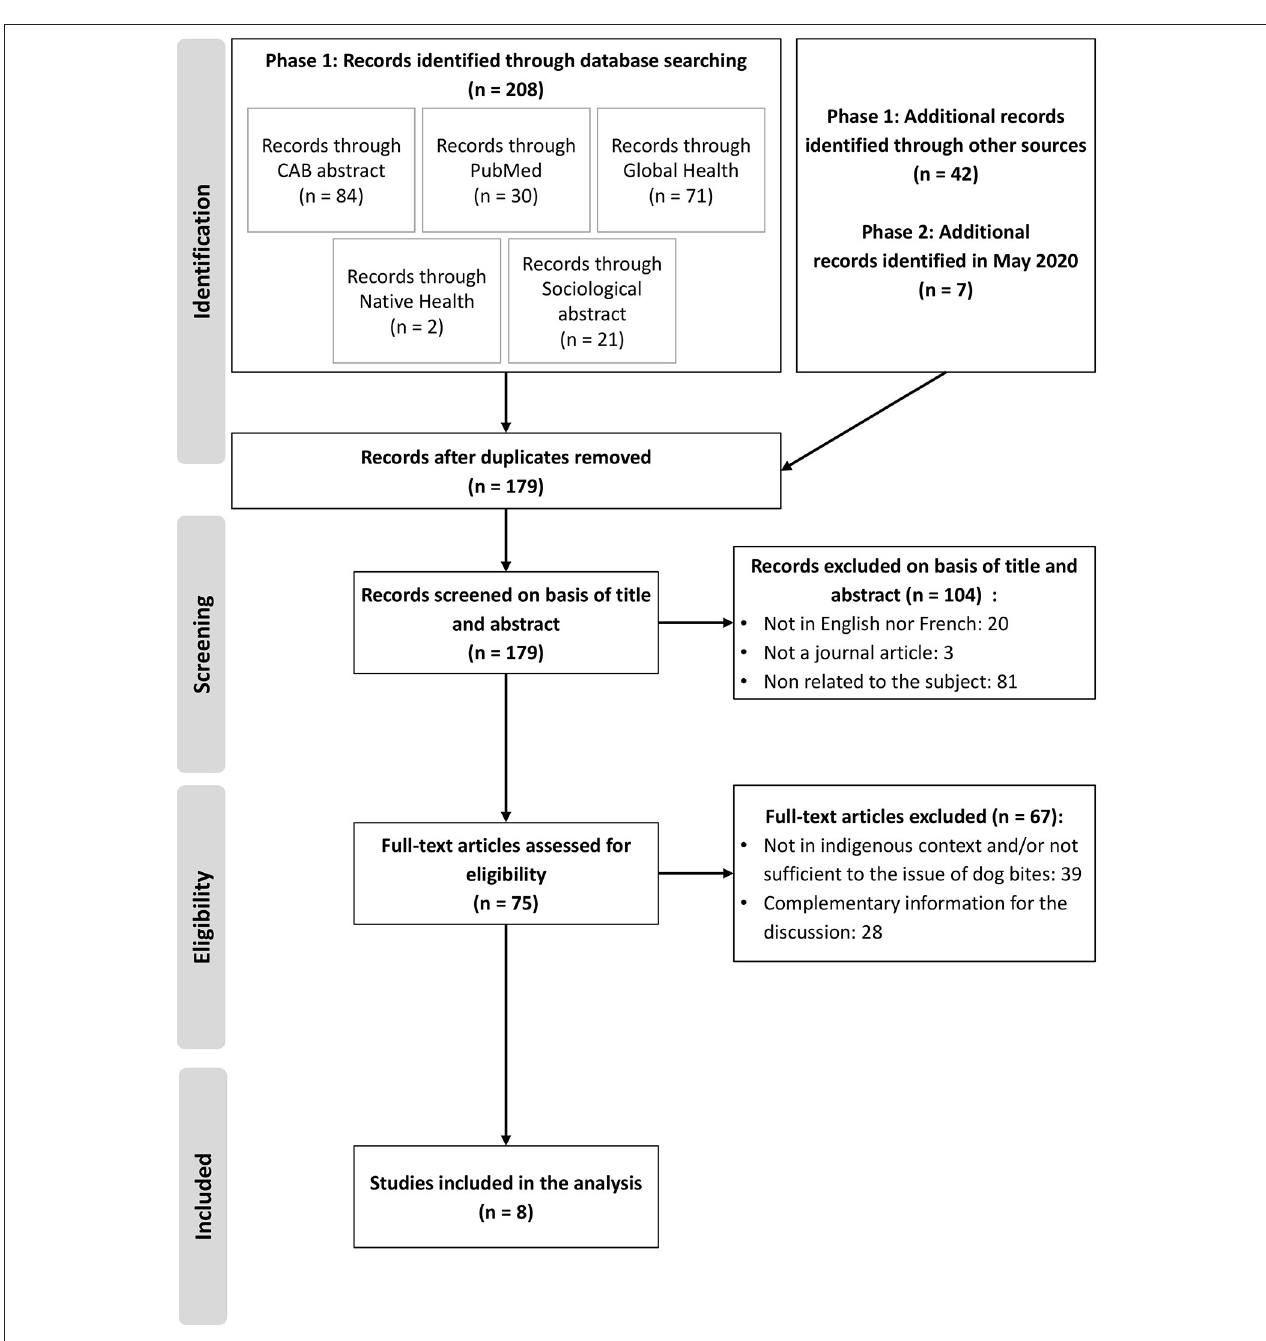
FIGURE 1 | PRISMA flowchart presenting the selection process